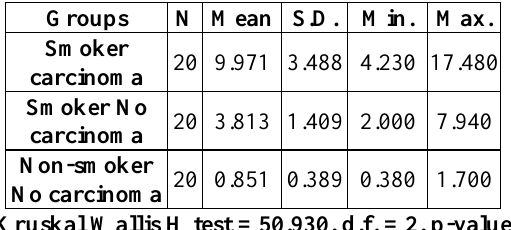
Table 1: Descriptive statistics of miRNA21 fold change among the three study Groups